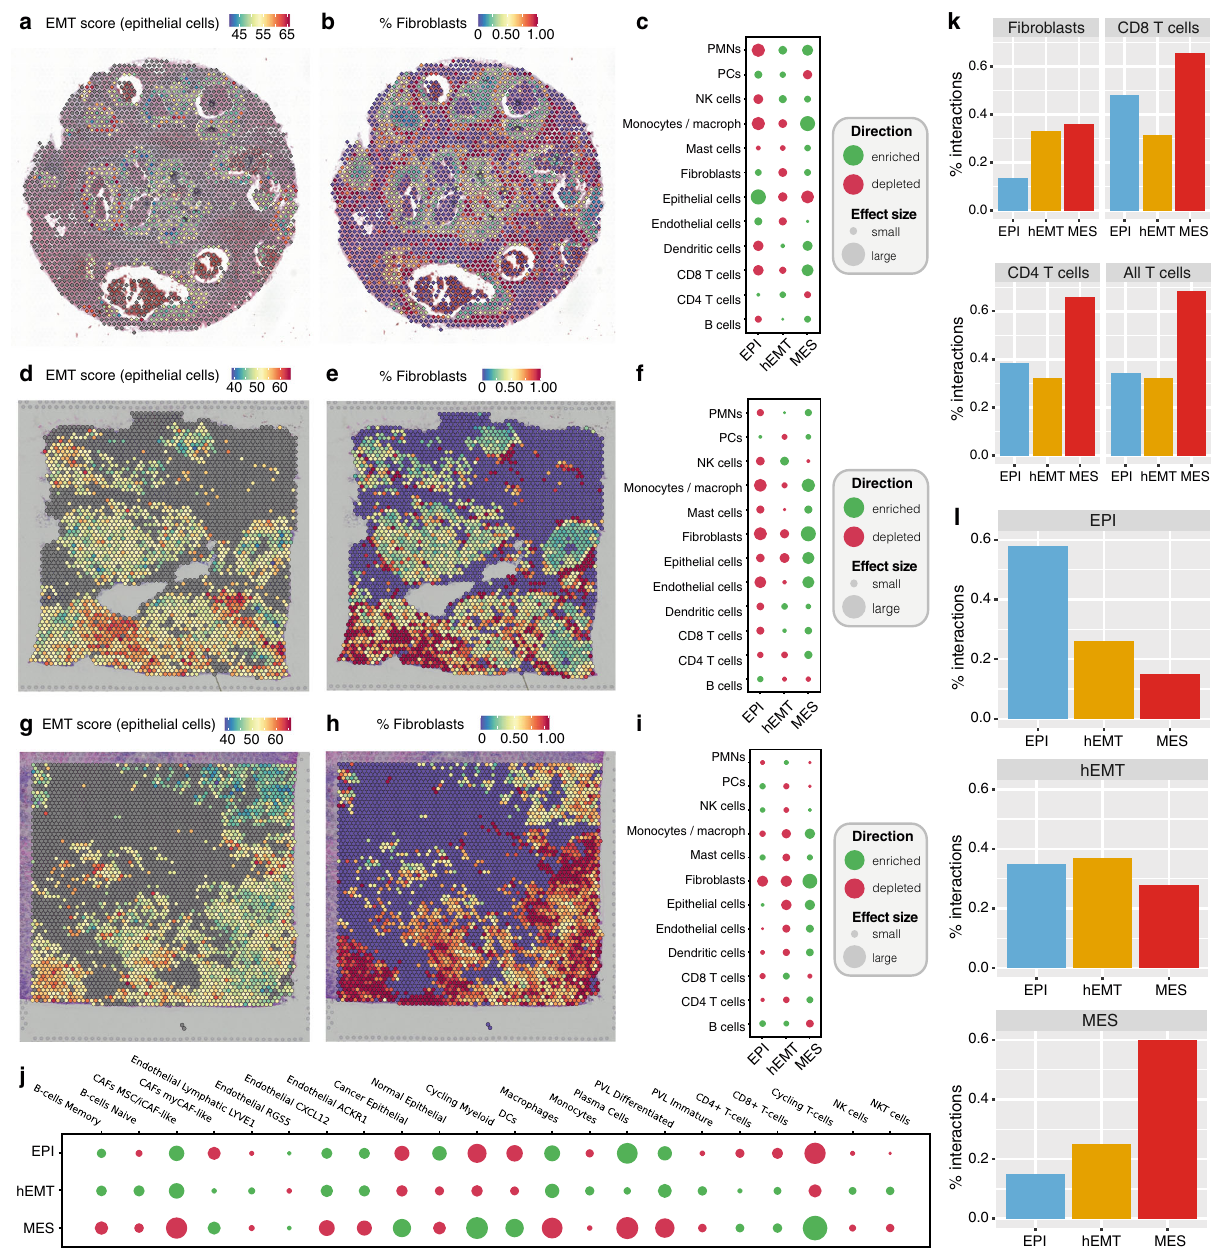
Fig.6|SpatialpatternsofEMT.a , b EMTscoresandthefractionof fi broblastsare visualised across within individual spots pro fi led across the tissue in a selected breast cancer slide, derived from spatial transcriptomicsdata from Patient 1 ofthe Visium dataset. The colour gradient re fl ects the expression of markers of the spe- ci fi c cell state (for EMT) or the fraction of cell types (for fi broblasts). c Enrichment and depletion of cell types in each EMT-based cluster from Patient 1. The plots representthedifferencebetweentheaveragecelltypeproportionvalueperregion, comparedtoapermutedspotvalue(calculated10,000times).Theplotmarkersize corresponds to the absolute enrichment score, and the colour represents the enrichmentsign.PMNpolymorphonuclearneutrophils,PCplasmacells,NKnatural killer, macroph macrophages. d – f The same annotations as above for a breast